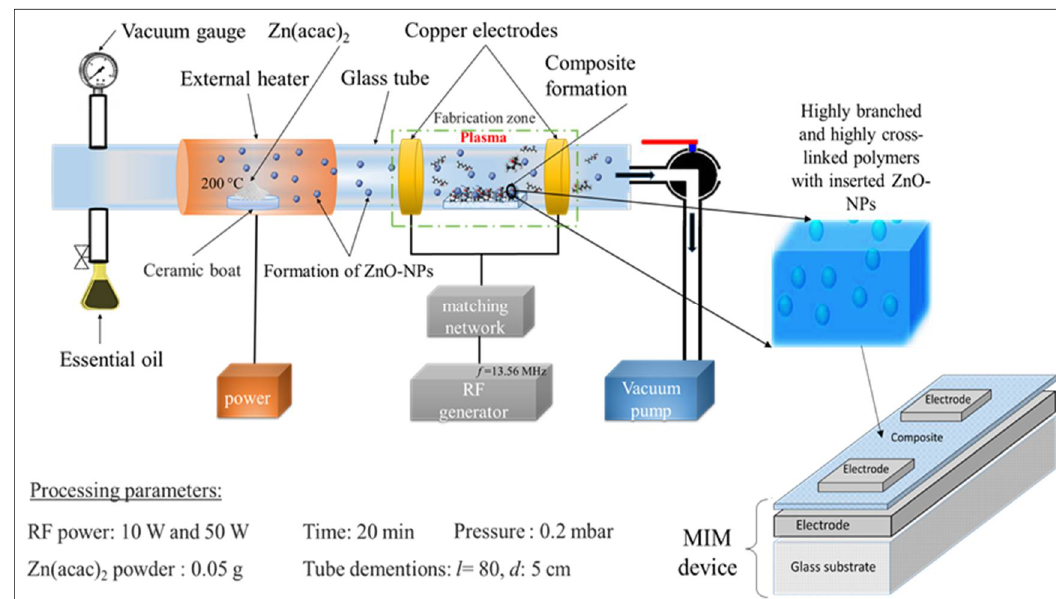
Figure 1. Schematic representation of the modified-plasma system used to manufacture plasma polymer/ZnO films. The metal–insulator–metal (MIM) design that was used to investigate the electrical properties of the resultant composites is also shown.